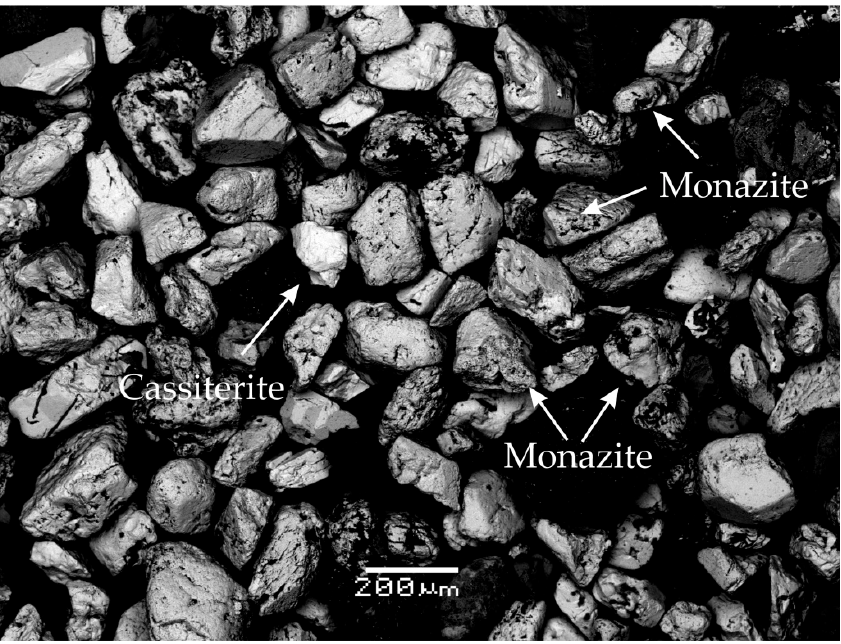
Figure 7. Weathered grains of monazite with numerous traces of dissolution on the grains surface SEM observation.